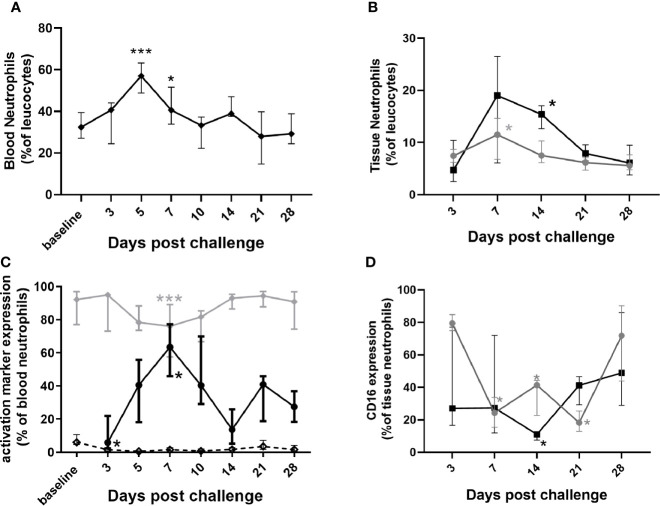
Changes in neutrophil populations in marmoset tissues at following inhalational challenge with C. burnetii. (A) blood (B) lung (grey circle) and spleen (black square) homogenates: (C) changes in activation/maturity marker expression CD16+ (dotted line), HLA-DR+ (gray diamond), and CD64+ (black circle)] on neutrophils in blood and (D) CD16+ expression on lung (gray circle) and spleen (black square) neutrophils. Data is median and interquartile range, significance from baseline or Day 3 by ANOVA; *p<0.05, and ***p<0.001.